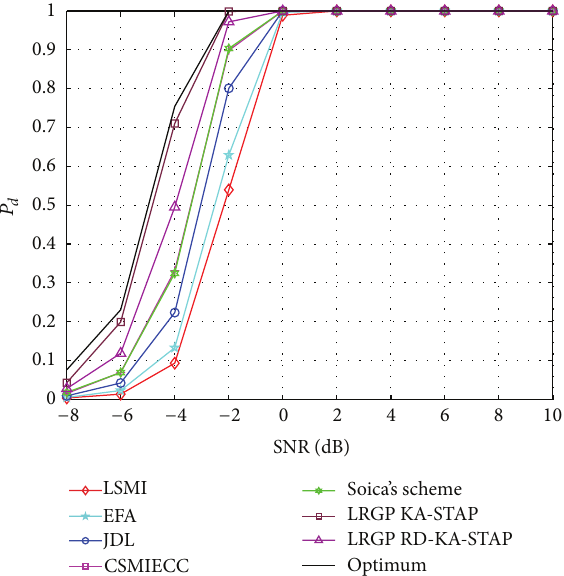
Figure 8: Probability of detection performance against the target SNR. Suppose the target is injected in the boresight with Doppler frequency 100Hz, and other parameters setting for all algorithms are the same as that in the second